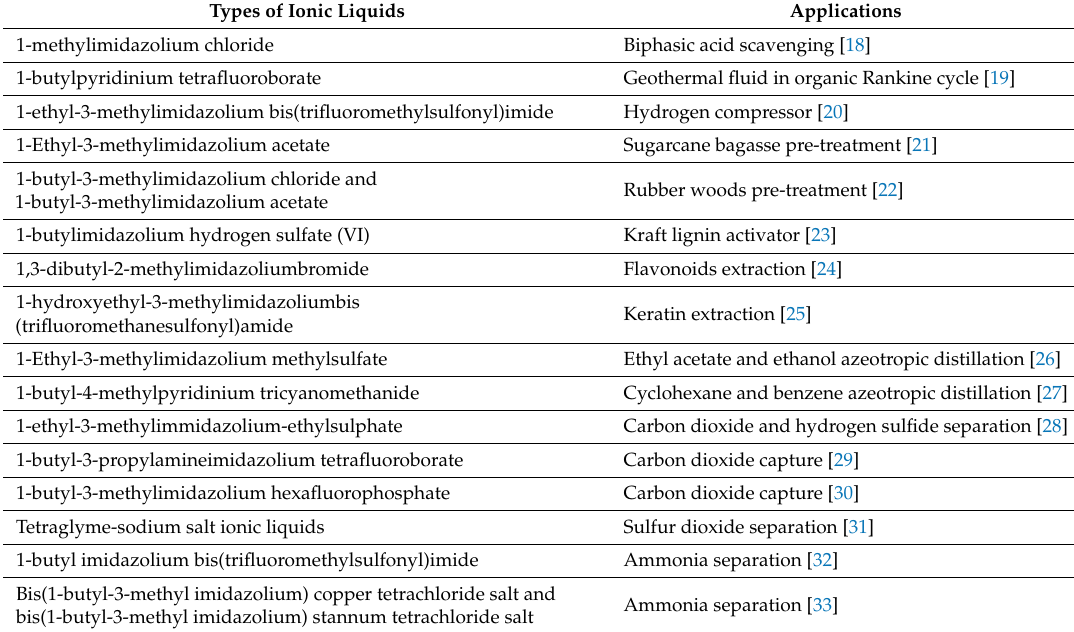
Table 1. Summary of potential applications of ionic liquids discussed in this